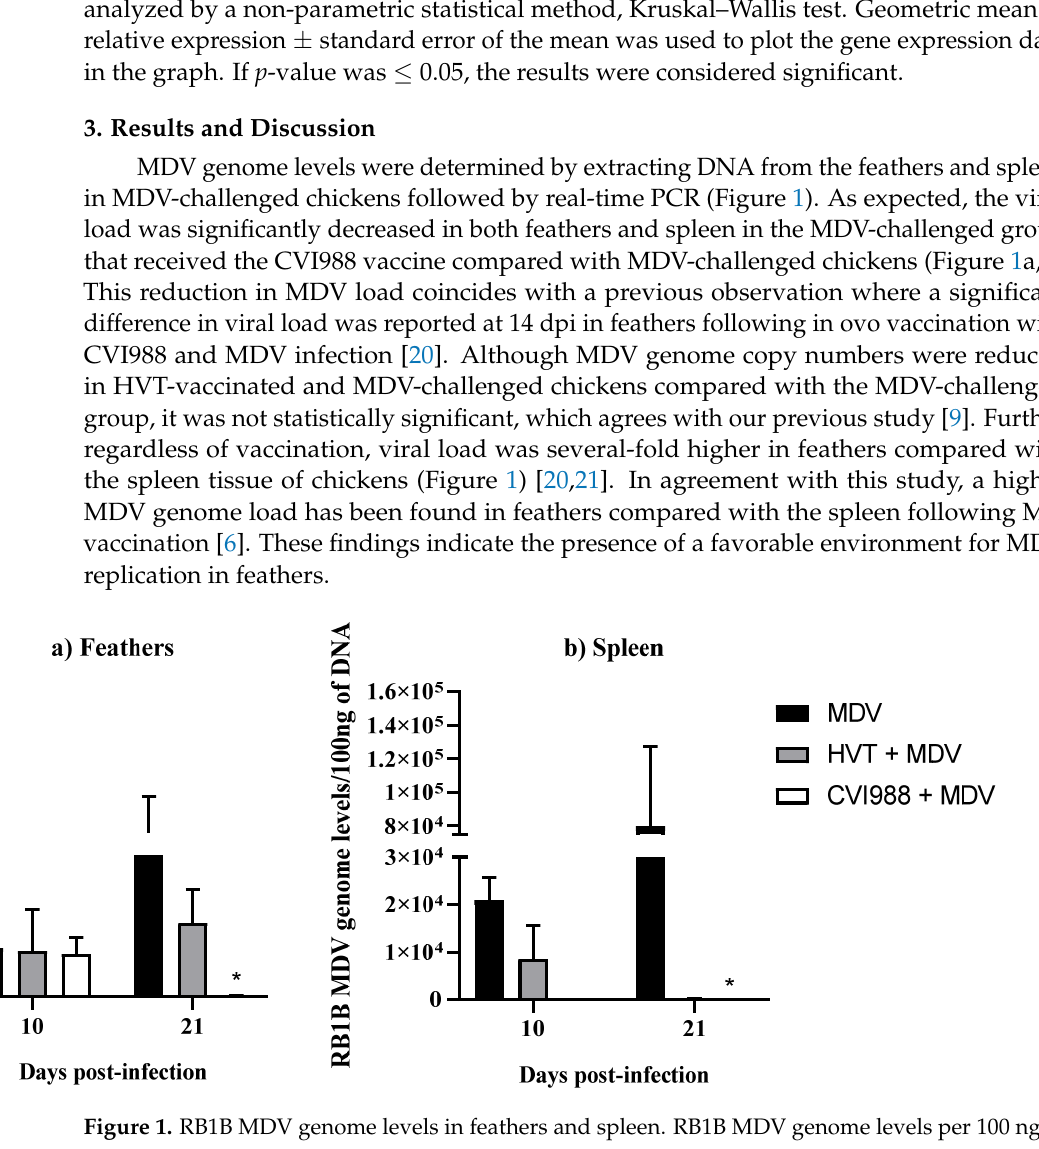
Figure 1. RB1B MDV genome levels in feathers and spleen. RB1B MDV genome levels per 100 ng of DNA were calculated from ( a ) feathers ( n = 8) and ( b ) spleen ( n = 8) collected at 10 and 21 dpi. Viral load data were analyzed by Kruskal–Wallis test. If p -value was ≤ 0.05, it was considered statistically significant (*). Each group was compared with the MDV-challenged group. Error bars indicate the standard error of the